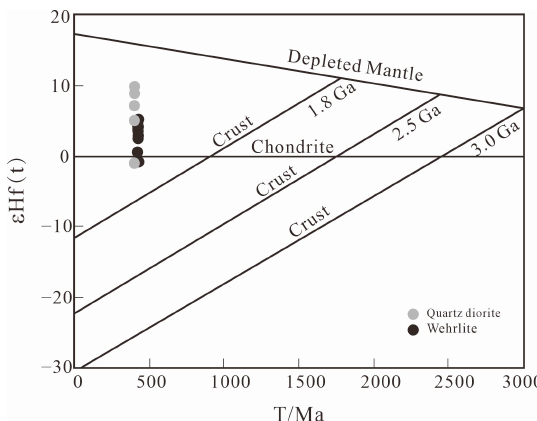
Figure 6. Zircon ε Hf(t) value versus zircon U-Pb age for the Gayahedonggou wehrlite and quartz diorite.